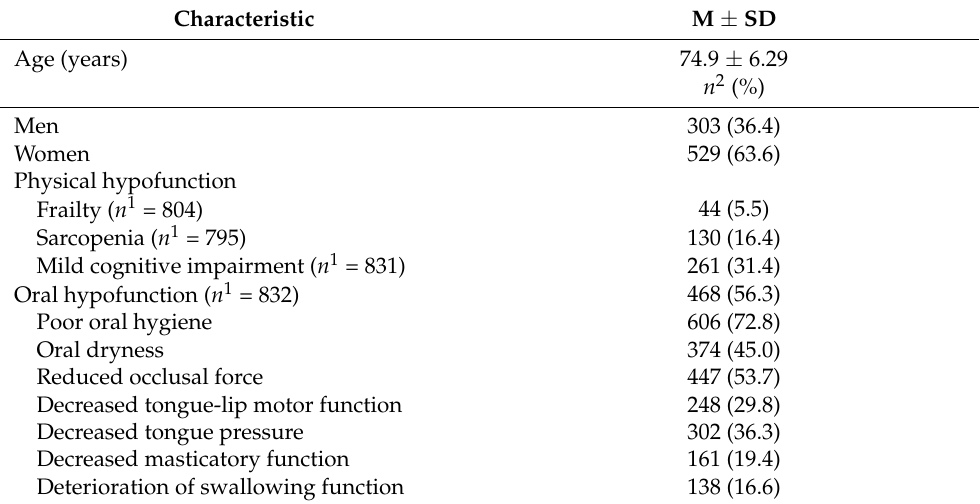
Table 1. Characteristics of the